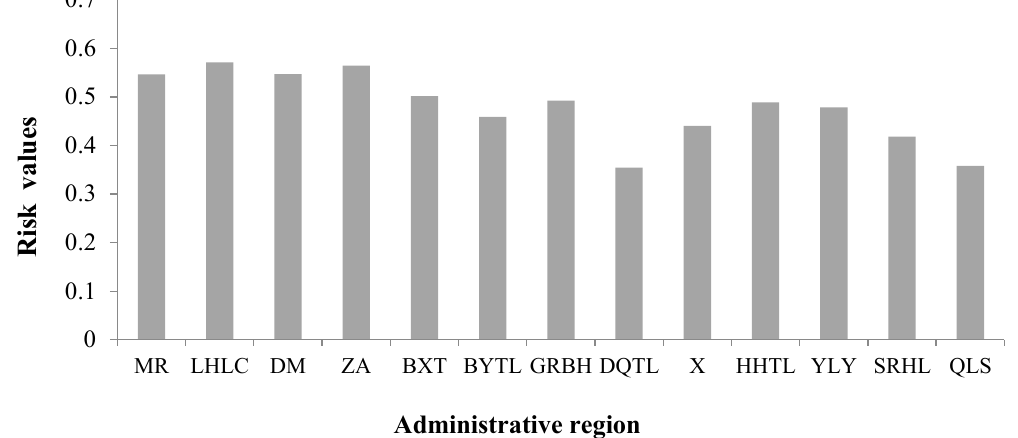
Figure 7. The desertification disaster risk in administrative region of Naiman Banner, which are minimum risk values of the Mingren (MR), Liuhaolinchang (LHLC), Dongming (DM), Zhian (ZA), Baxiantong (BXT), Bayintala (BYTL), Guribenhua(GRBH), Daqintala (DQTL), Xin (X), Huanghuatala (HHTL), Yilongyong (YLY), Sharihaolai (SRHL) and Qinglongshan (QLS).